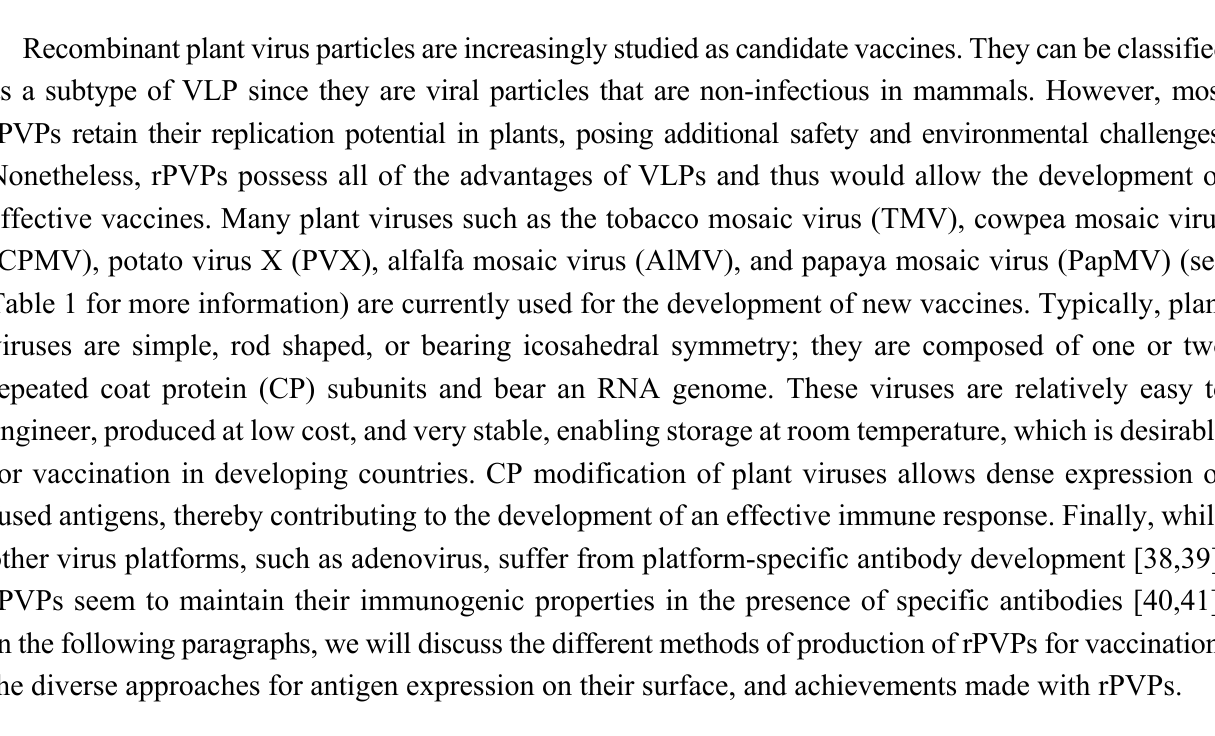
Table 1. Recombinant plant virus particles used in vaccine